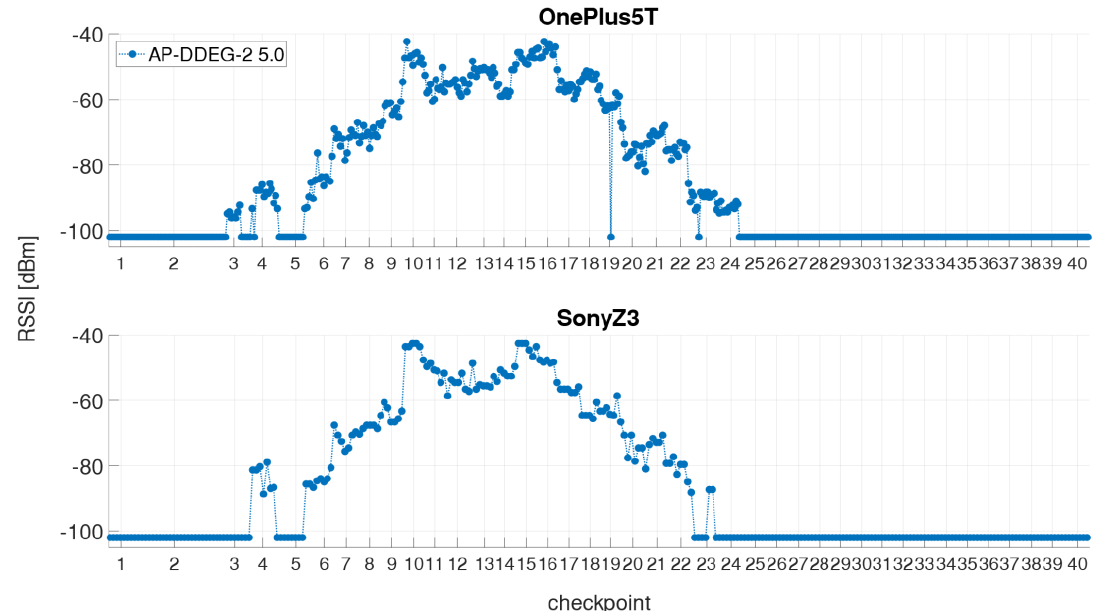
Figure 4. Examples of a stop-and-go measurement run for the two smartphones ( top ) OnePlus 5T and ( bottom ) Sony Z3 which measured simultaneously.